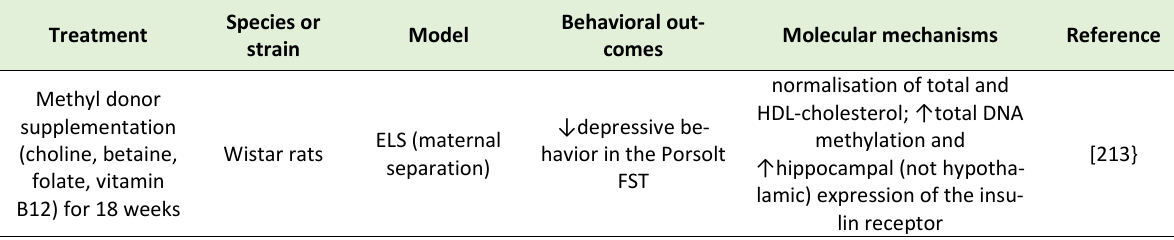
TABLE 7. Studies investigating the effects of choline metabolites on depressive-like behavior. Species Treatment